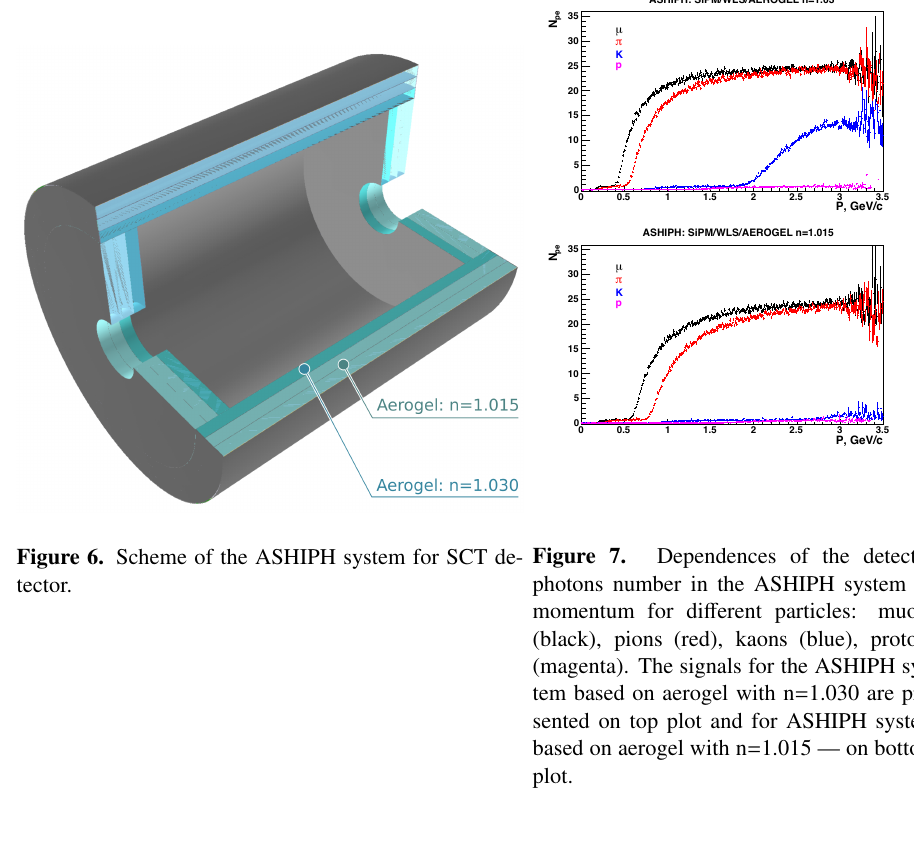
Figure 6. Scheme of the ASHIPH system for SCT de- tector.